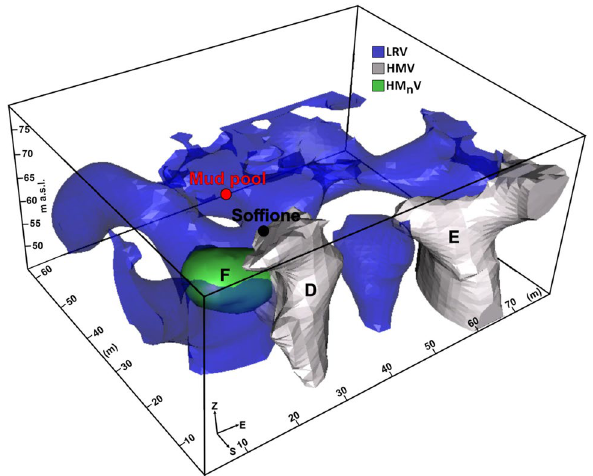
Figure 4. Sketch of the high-chargeability volume (HMV, in light gray) and the high normalized chargeability volume (HMnV, in light green) discussed in the text. Additionally, the LRV (see Fig. 3) is represented in blue. A threshold value of 10 mV/V was selected for electrical chargeability, whereas a cutoff value of 5 was selected for normalized chargeability. The figure was created by the Visit 3.1.2 open-source software (https:// wci. llnl. gov/ simul ation/ compu ter- codes/ visit) produced by the Lawrence Livermore National Laboratory (USA) and postprocessed using the Corel Draw 17 commercial software (https:// www. corel draw. com/ it/ produ ct/ corel draw/).